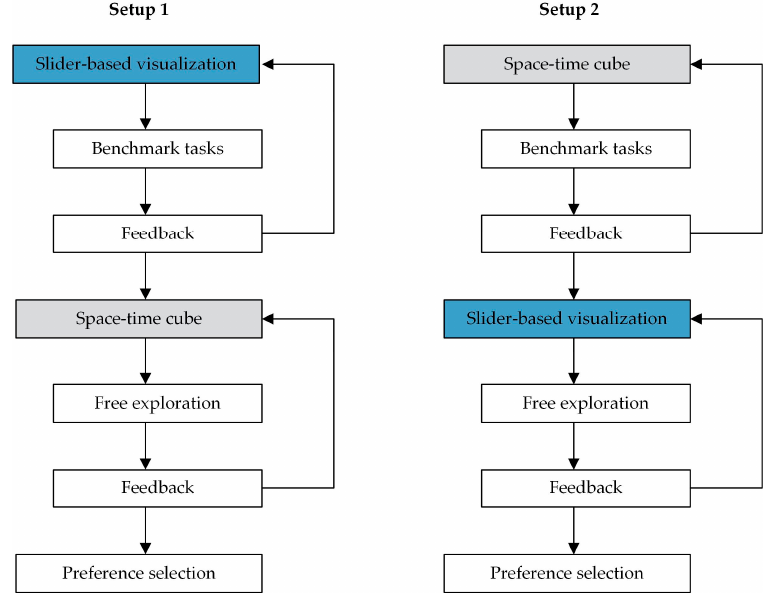
Figure 6. The overview of the experiment setups with two feedback loops on the presented spatiotemporal visualizations.